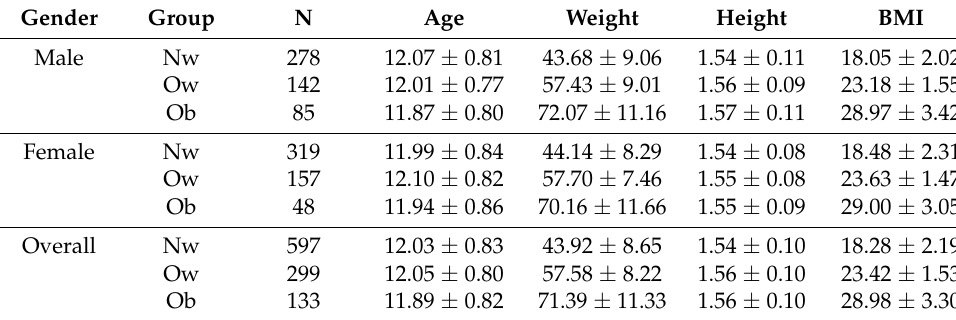
Table 1. Anthropometric characteristics of the